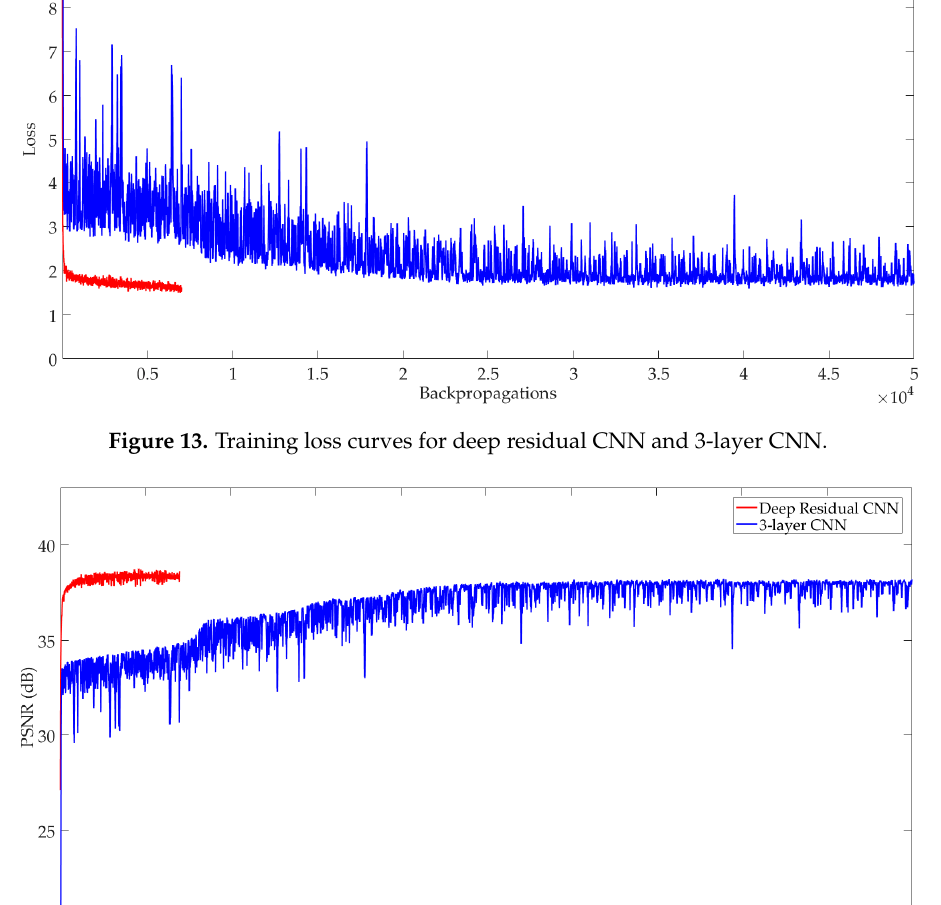
Figure 14. Testing PSNR curves for deep residual CNN and 3-layer CNN.